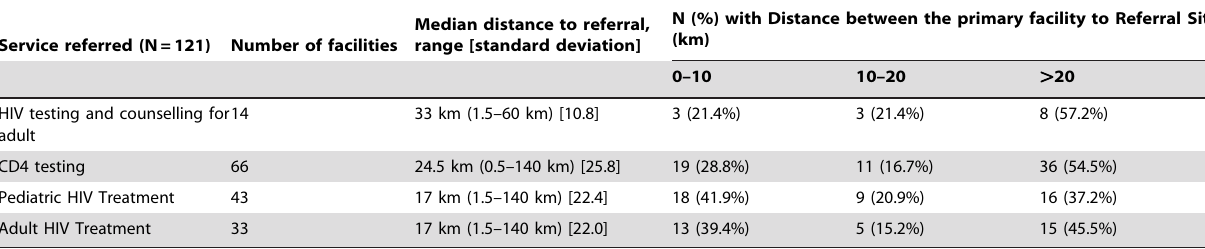
Table 2. Referral services needed and distance from the primary facilities (N